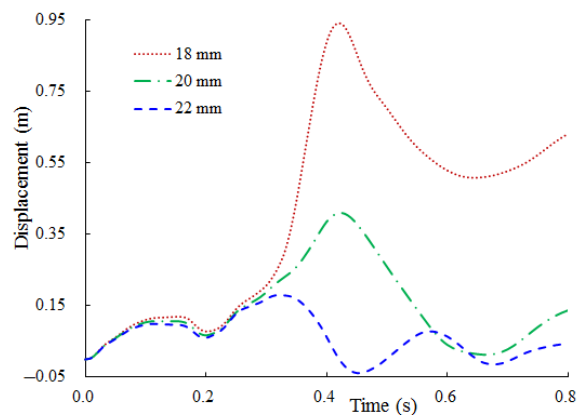
Figure 17. Max displacement time-history of containment.